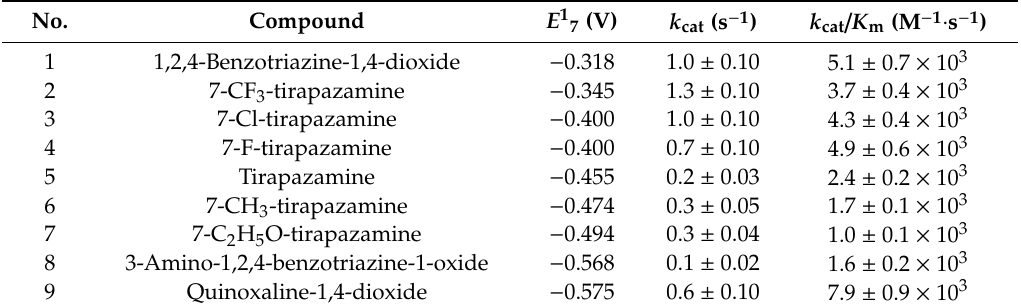
Table 2. The single-electron reduction midpoint potentials ( E 1 7 ) of aromatic N- oxides and the steady-state rate constants of their reduction by